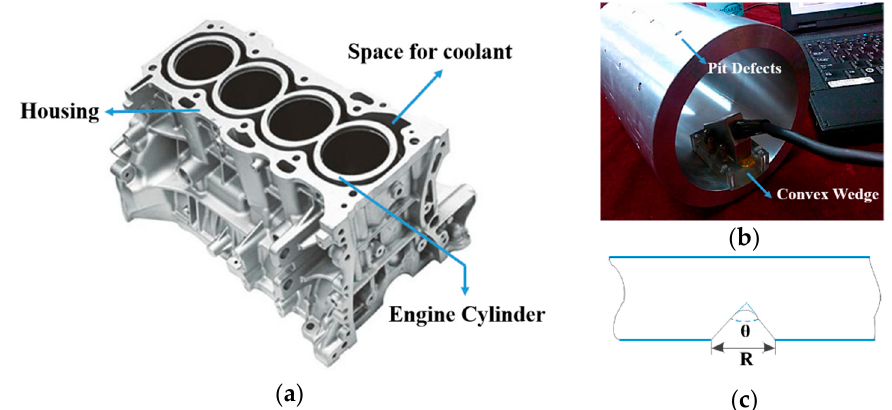
Figure 24. ( a ) The structure of engine cylinder; ( b ) The experimental system; ( c ) The details of pit defects.